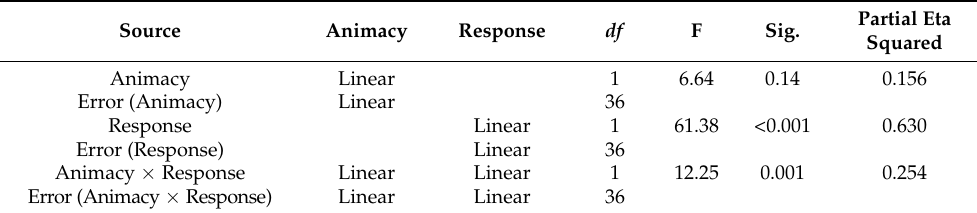
Table 5. Tests of Within-Subjects Contrasts from two-way repeated ANOVA for RAN Object. Source